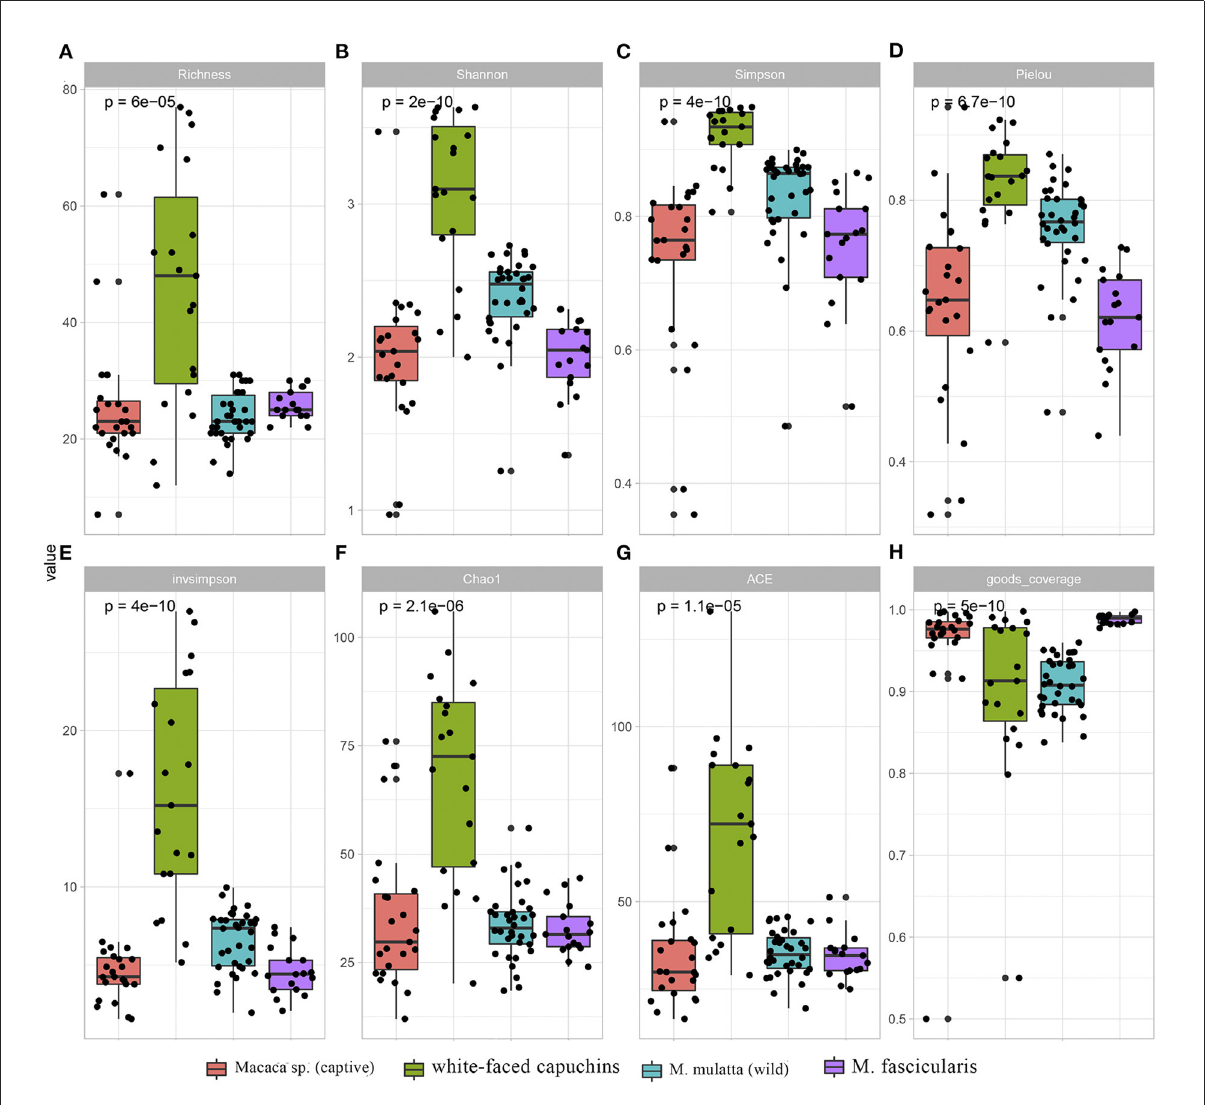
FIGURE1 Comparison of ARGs diversity index and richness index across Macaca sp. (captive) , M. mulatta (wild), white-faced capuchins and M. fascic ularis. (A) Richness index (B) Shanno index (C) Simpson index (D) Pielou index (E) invsimpson index (F) Chao1 (G) ACE (H) goods_coverage.